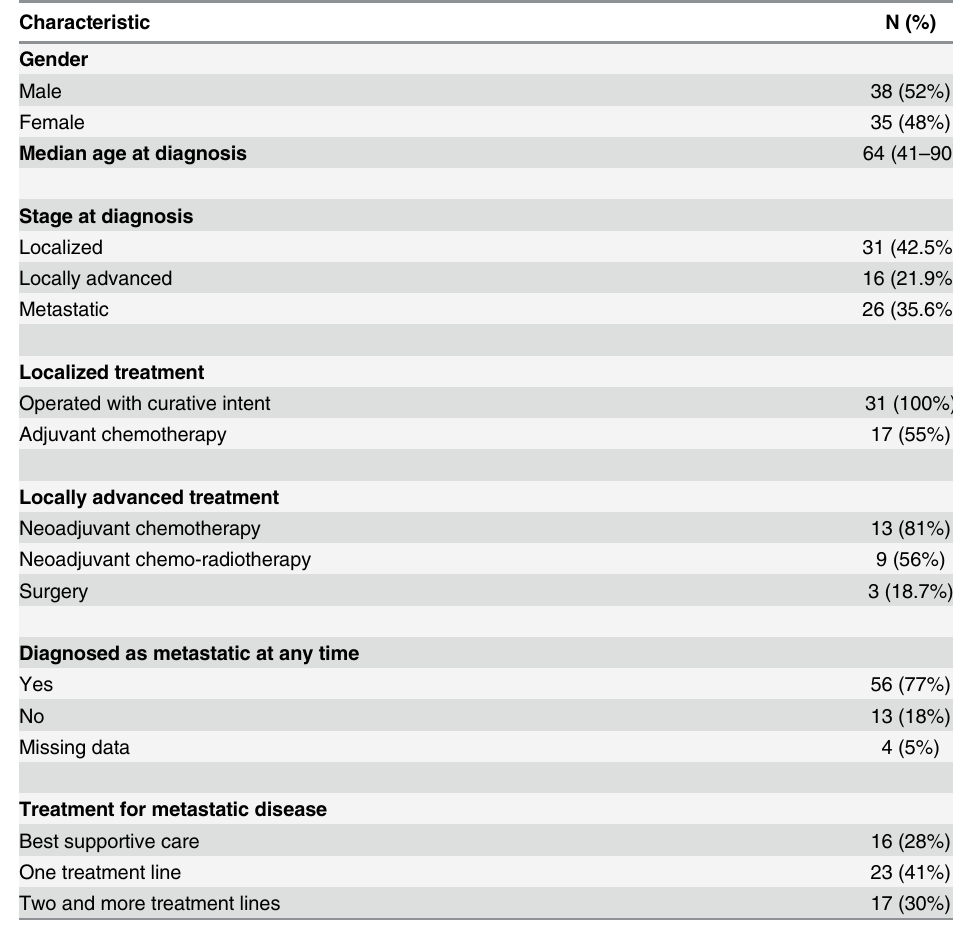
Table 1. Clinical Characteristics of All Patients (N =